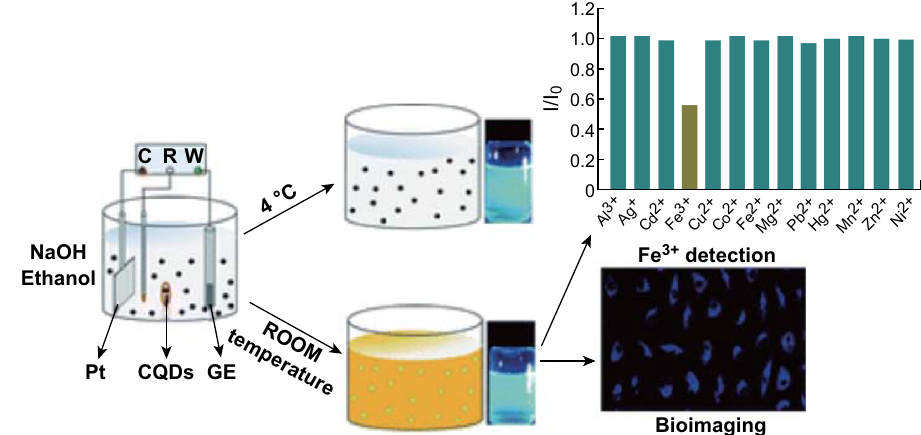
Fig. 3 Schematic illustration of CQD generation via electrochemical oxidation of a graphite electrode in alkaline alcohols. The color change of the dispersion during room temperature storage is due to oxygenation of the surface species [21]. Copyright (cid:2) 2016 The Royal Society of Chemistry. (Color figure